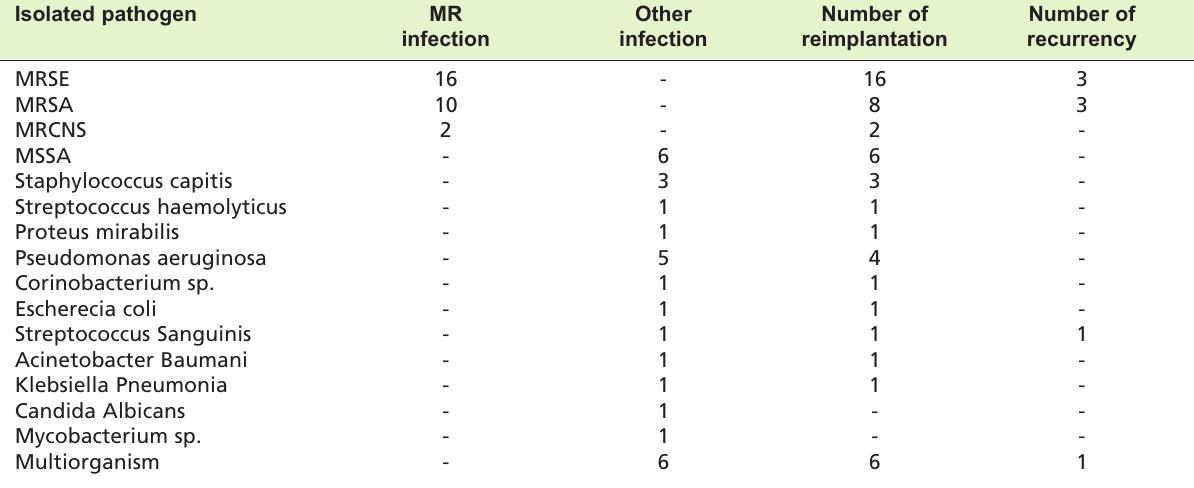
List of isolated pathogen in Methicillin-resistant group versus control group Table III: